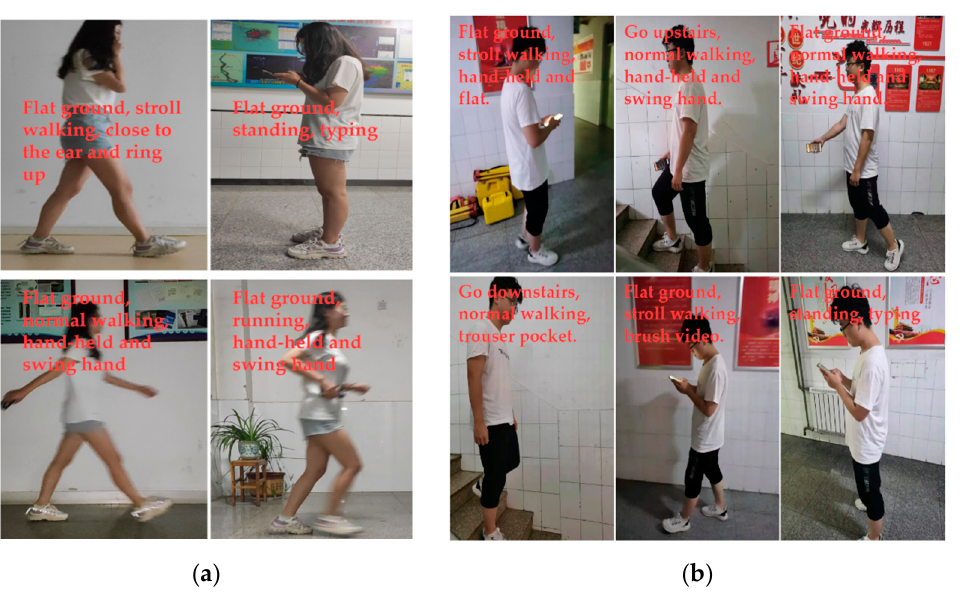
Figure 13. Unconstrained experiment process: ( a ) Schematic diagram of the second group of experimental process ( b ) Schematic diagram of the fourth group of experimental process.